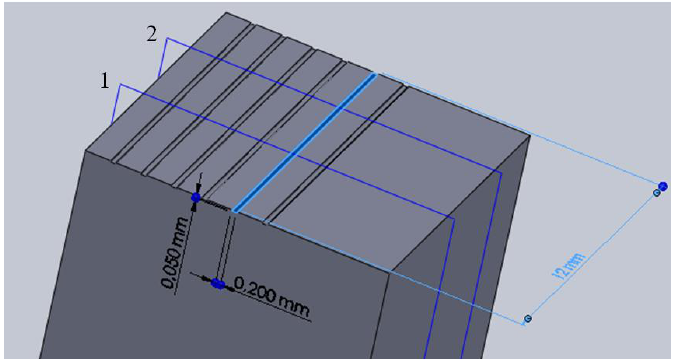
Figure 4. Sample and micro channel